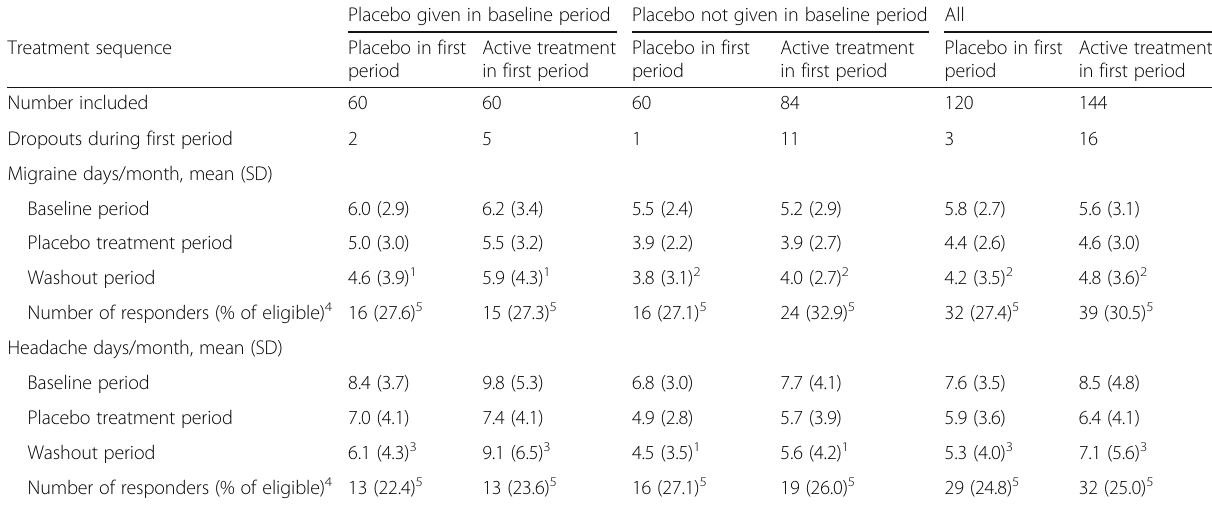
Table 3 Number of dropouts and days with headache and migraine per 4 weeks related to treatment sequence and use of placebo in baseline period ( N = 264)